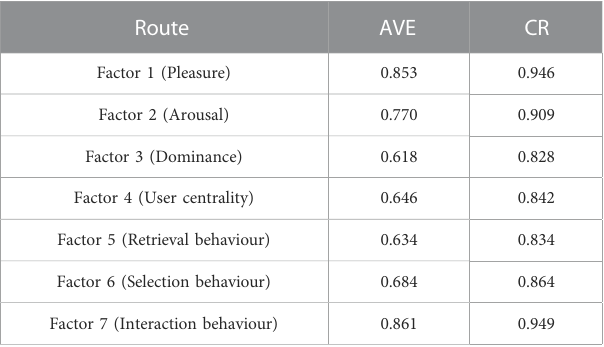
TABLE 8 Factor convergent validity test